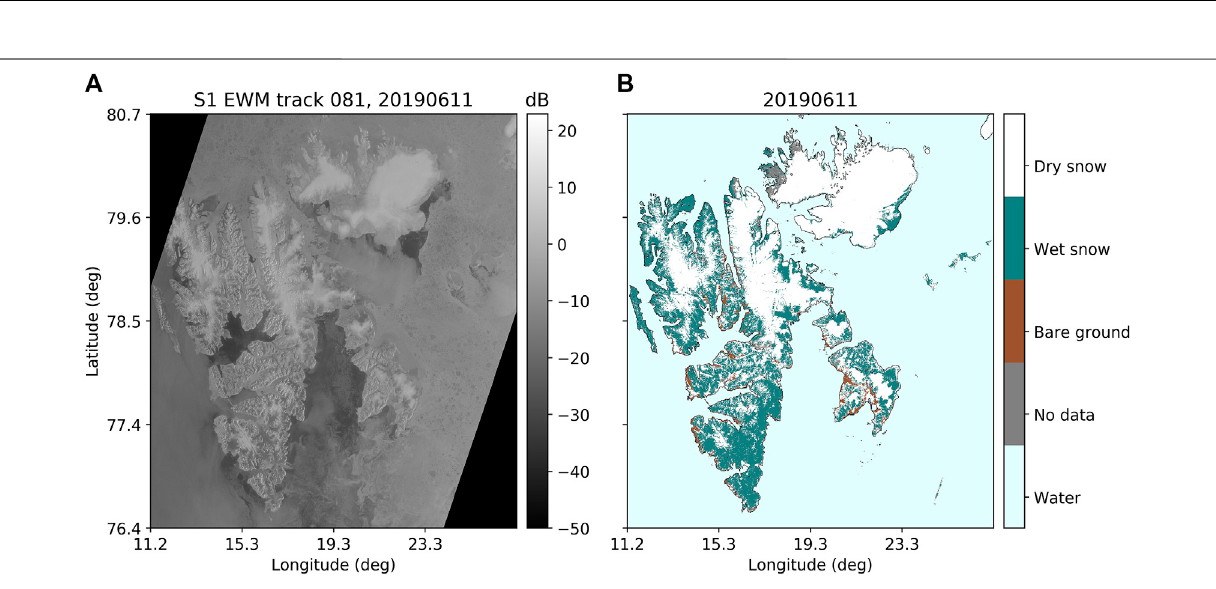
Frontiers in Earth Science |